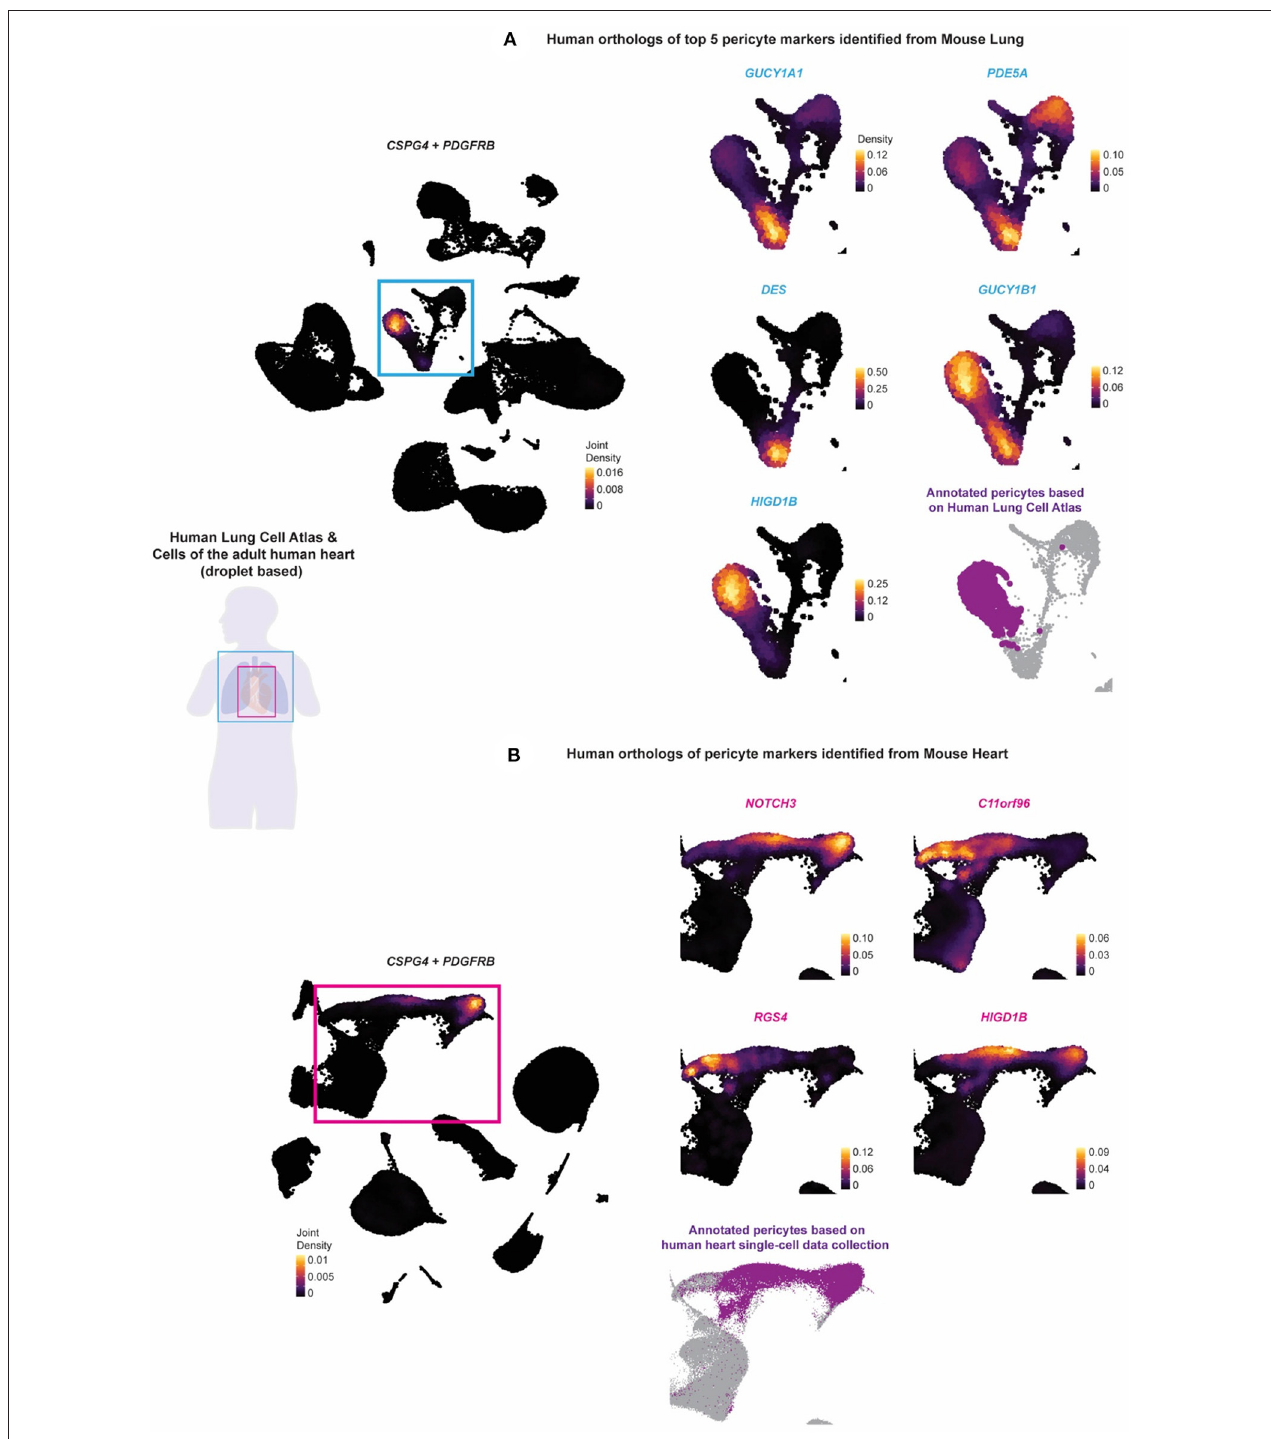
FIGURE 4 | The identified murine lung and pericyte markers are tested on human lung and heart scRNAseq data. The expression of human orthologs of the potential pericyte markers identified from the stringent pericytes of the mouse lung and heart tissue were tested against the (A) Human Lung Cell Atlas and the (B) collection of the cells of the adult human heart to validate whether they can be used to annotate pericytes in the human lung and heart tissue. Purple (fond color) indicated the annotated pericytes of the two human datasets. The Human Lung Cell Atlas annotated pericytes based on CSPG4 , PDGFRB , and TRPC6 , while the human heart pericytes were annotated based on RGS5 , ABCC9 , and KCNJ8 . Light blue (fond color) genes indicated the human orthologs of the top 5 potential pericyte markers identified from the mouse lung. Pink (fond color) genes indicated the human orthologs of all the potential pericyte markers identified from the mouse heart.